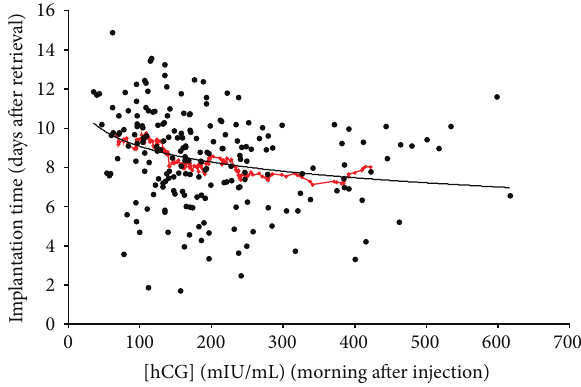
Figure 3: Time to implantation (days) as a function of serum hCG level the morning after 10 000 units ovulatory injection. The mean time to implantation was 8.6 ± 2.3 days ( 𝑛 = 113 ). There was an inverse correlation between implantation time and serum hCG ( 𝑅 = −0.335 ).Arollingaverageoftheimplantationtime(redcircles) was longer (9–10.5 days) when the postinjection serum hCG levels were lower ( ∼ 100mIU/mL) when compared to an implantation time of ∼ 8 days when the postinjection serum hCG levels were higher (250–400 mIU/mL). There was a significant inverse association (regression equation, smooth line) between implantation time and serum hCG level ( 𝑝 = 9 × 10 −7